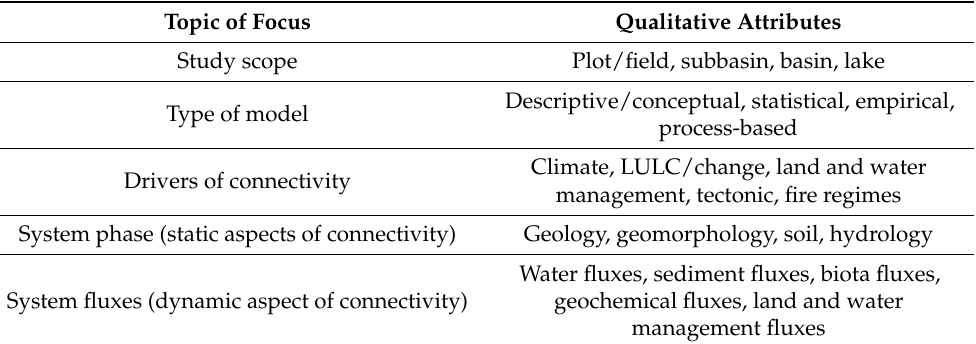
Table 2. Topic of focus considered to classify and analyze the 135 research papers relating to climate, hydrology and geomorphology of the Lake Tana Basin. Topic of Focus Qualitative Attributes Study scope Plot/field, subbasin, basin, lake Descriptive/conceptual, statistical, empirical, Type of model process-based Drivers of connectivity